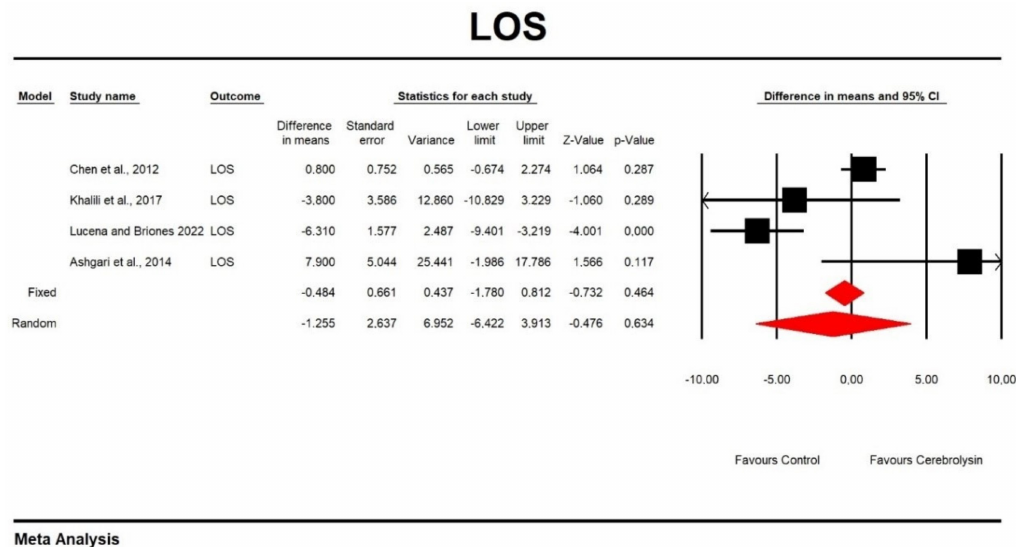
Figure 5. Effect of Cerebrolysin on LOS (Z value = − 0.476, p = 0.634).